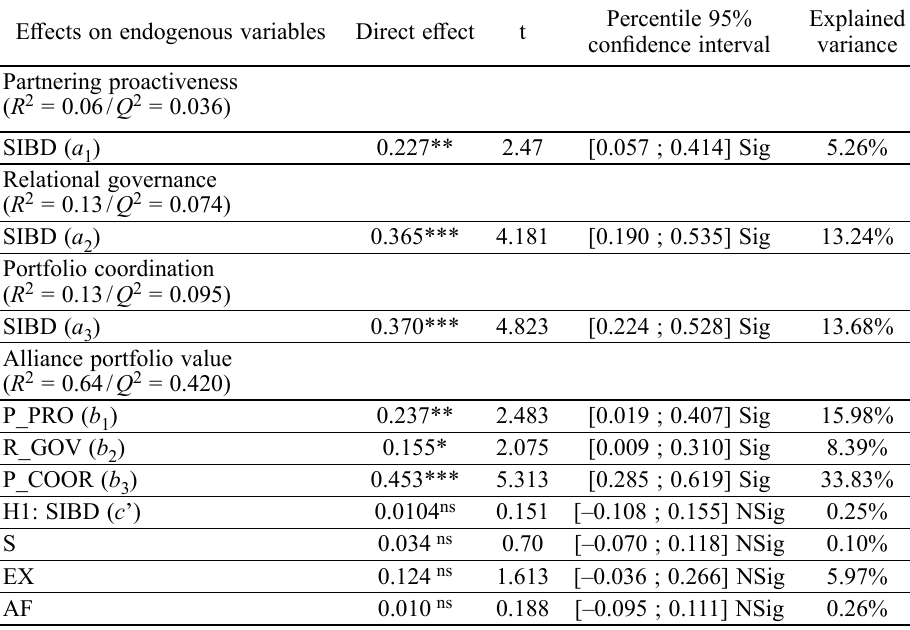
Fig. 1. Structural models Table 3. Effects on endogenous variables